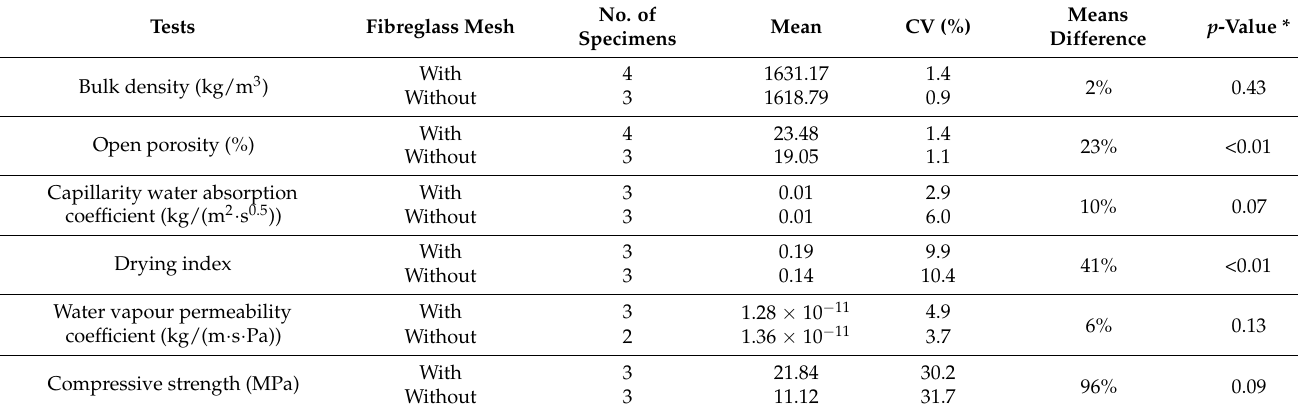
Table 13. Air lime mortar applied to the natural stone substrate.